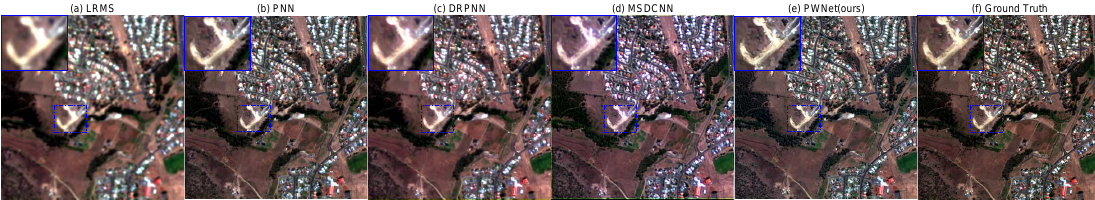
Figure 12. Visual comparison of the CNN-based methods on the GeoEye-1 data set, ( a ) LRMS; ( b ) PNN; ( c ) DRPNN; ( d ) MSDCNN; ( e ) PWNet (ours); ( f ) Ground